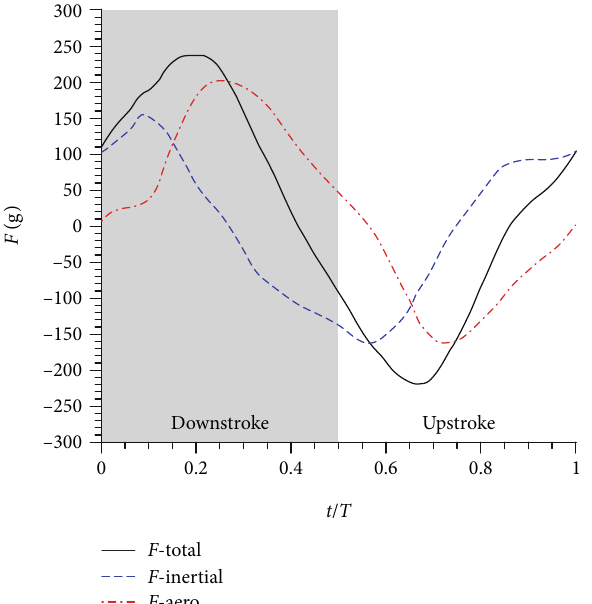
Figure 13: Relationship between the inertial and aerodynamic forces in a fl apping cycle.